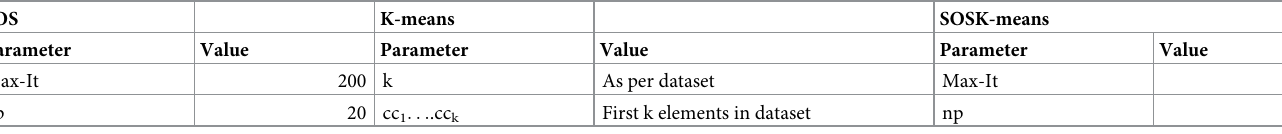
Table 2. Initial parameter setting for classical SOS, classical K-means and proposed hybrid SOSK-means. SOS